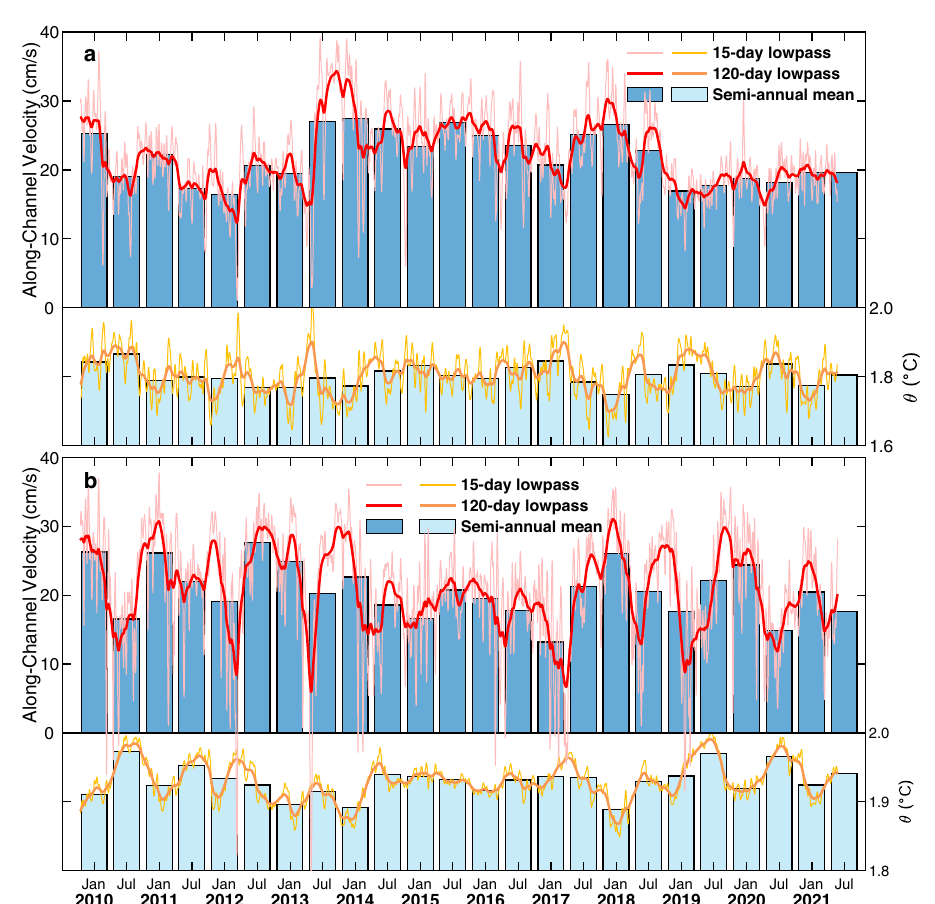
Fig. 3 | Variabilityof the LuzonStrait over fl ow. Fifteen-daylowpass(thinlinesin pink and yellow), 120-day lowpass (thick lines in red and orange), and semi-annual mean (blue and cyan bars) series of along-channel velocity and potential tem- perature ( θ ) of the deepest instruments at a BC and b LT are shown,